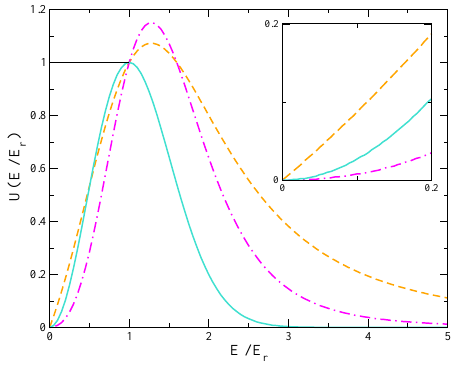
Figure 1. Examples of Eq. (9) (dashed line), Eq. (10) (dot- dashed line) and Eq. (11) (solid line), with detail of low- E gion.